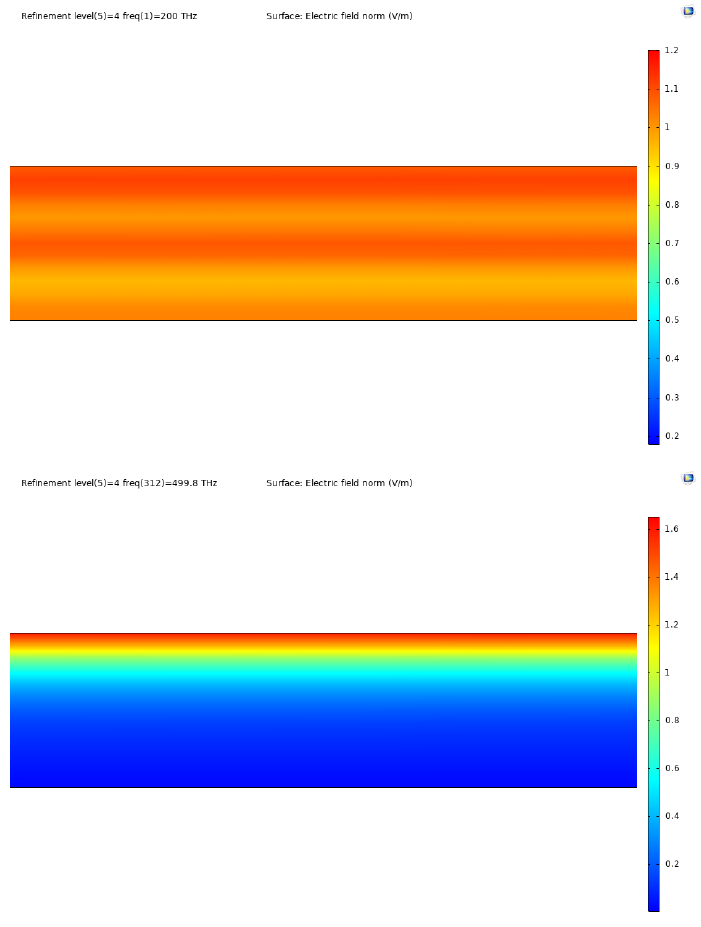
Figure A2. Electric field norm of GaAs at 200 THz and 500